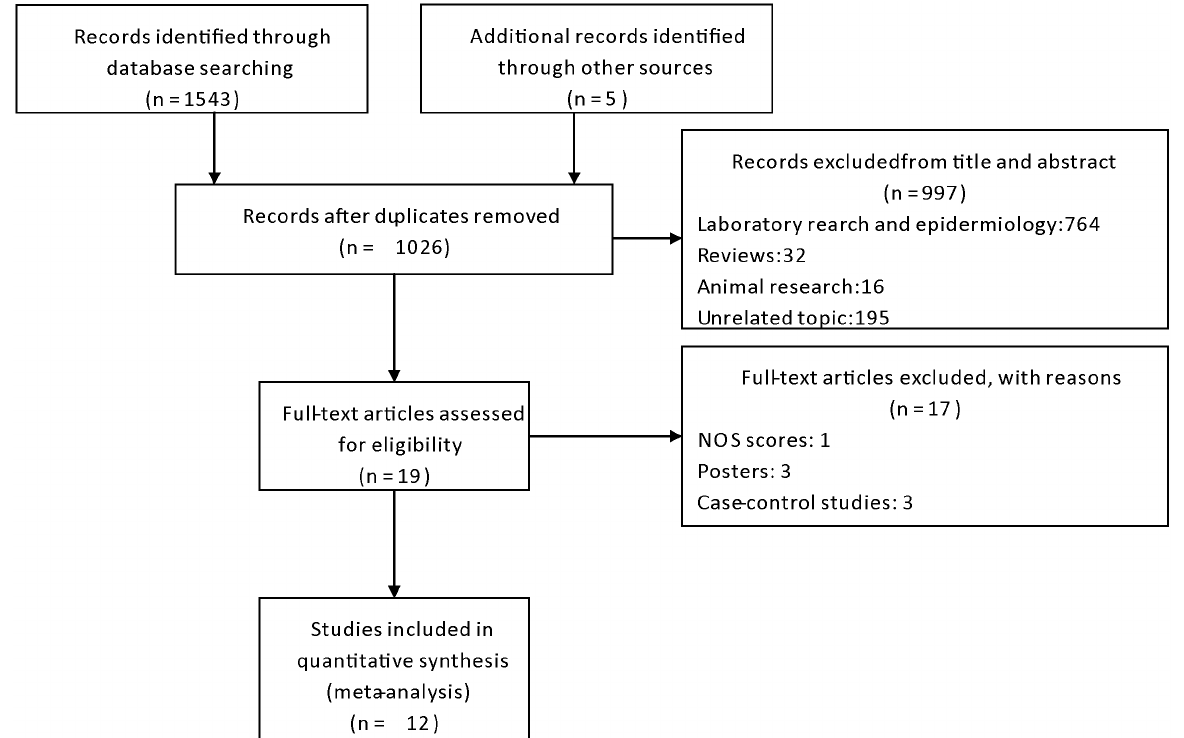
Figure 1. Flow diagram of included studies.